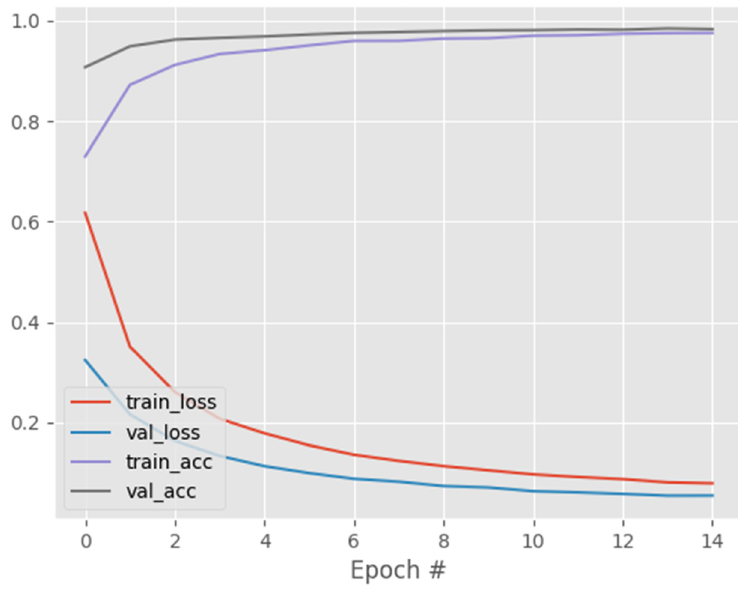
Figure 7. DenseNet121 training and validation performance.